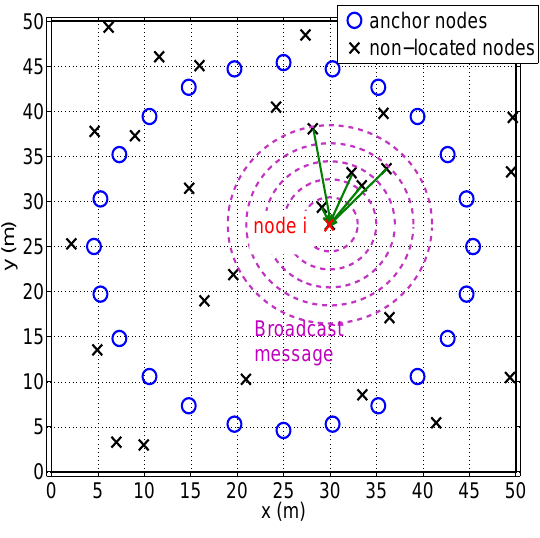
Figure 4. Example of the creation of a group S i .